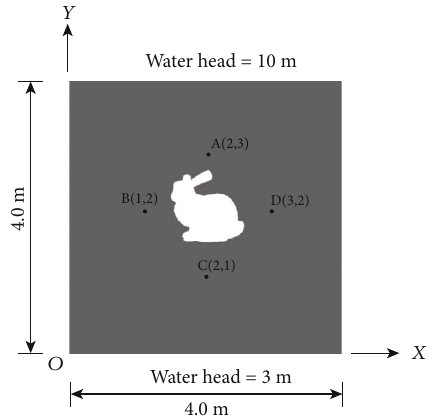
Figure 10: Geometry and boundary conditions for a square plate with a Stanford bunny